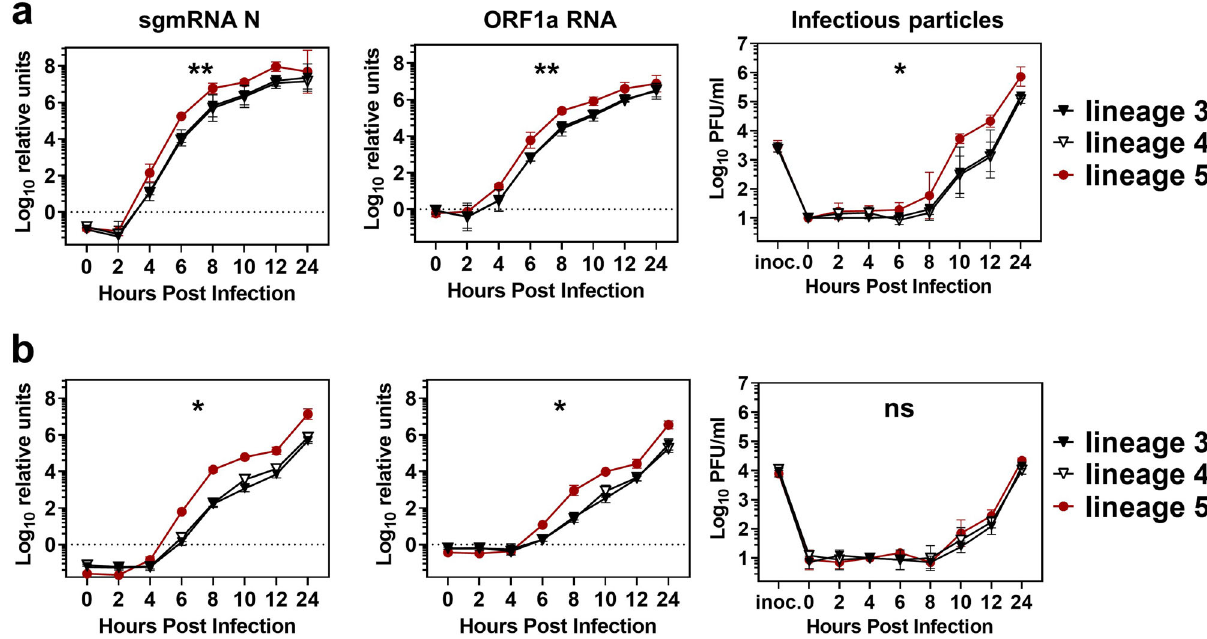
Fig. 6 Subgenomic nucleocapsid RNA, ORF1a, and PFU quanti fi cation at early stages of infection. a Calu-3 and b Vero B4 cells were infected at an MOI of 0.002 with one virus isolate of each phylogenetic lineage in biological duplicates for each indicated time point in n = 2 independent experiments. At the indicated time points, cell culture supernatant was harvested and subjected to virus quanti fi cation by plaque assay. Infected cells were lysed and total RNA was isolated and subjected to quanti fi cation by q-RT-PCR of sgmRNA N and ORF1a RNA, normalized to the housekeeping gene TBP, and the amount of RNA at 0 hpi. Shown are the combined data of two independent experiments. Statistical signi fi cance of variance in virus replication between groups was analyzed by one-way ANOVA. Signi fi cant differences were found for sgmRNA N (in a ) Calu-3: **; p = 0.0026; in b ) Vero B4: *; p = 0.0276), for ORF1a RNA (in a ) Calu-3: **; p = 0.0035; in b Vero B4: *; 0.0418) and for PFU/ml in Calu-3 (*; p = 0.0139) PFU, plaque forming units; sgmRNA N, subgenomic nucleocapsid mRNA; ORF, open reading frame.